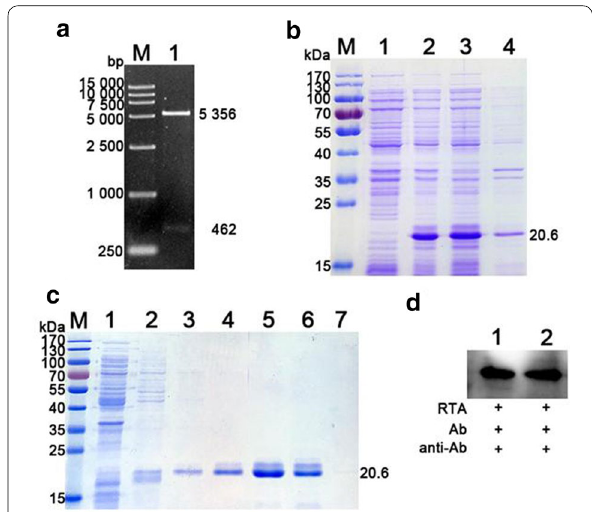
Fig. 2 The construction, prokaryotic expression, purification and verification of RTA protein. a The electrophoresis result of the pET28a-RTA recombinant plasmid double enzyme digestion. M, 15 000 bp marker; 1, pET28a-RTA recombinant plasmid. b The expression of the RTA protein in different fractions of E. coli cultures. M, 170 kDa marker; 1, noninduced bacteria; 2, induced bacteria; 3, supernatant after sonication; and 4, precipitate after sonication. c The purification of the RTA protein. M, 170 kDa marker; and 1–7, the sample eluted with 10, 20, 40, 60, 80, 100, and 250 mM imidazole, respectively. d Western blotting results for the RTA protein. 1, Sample before